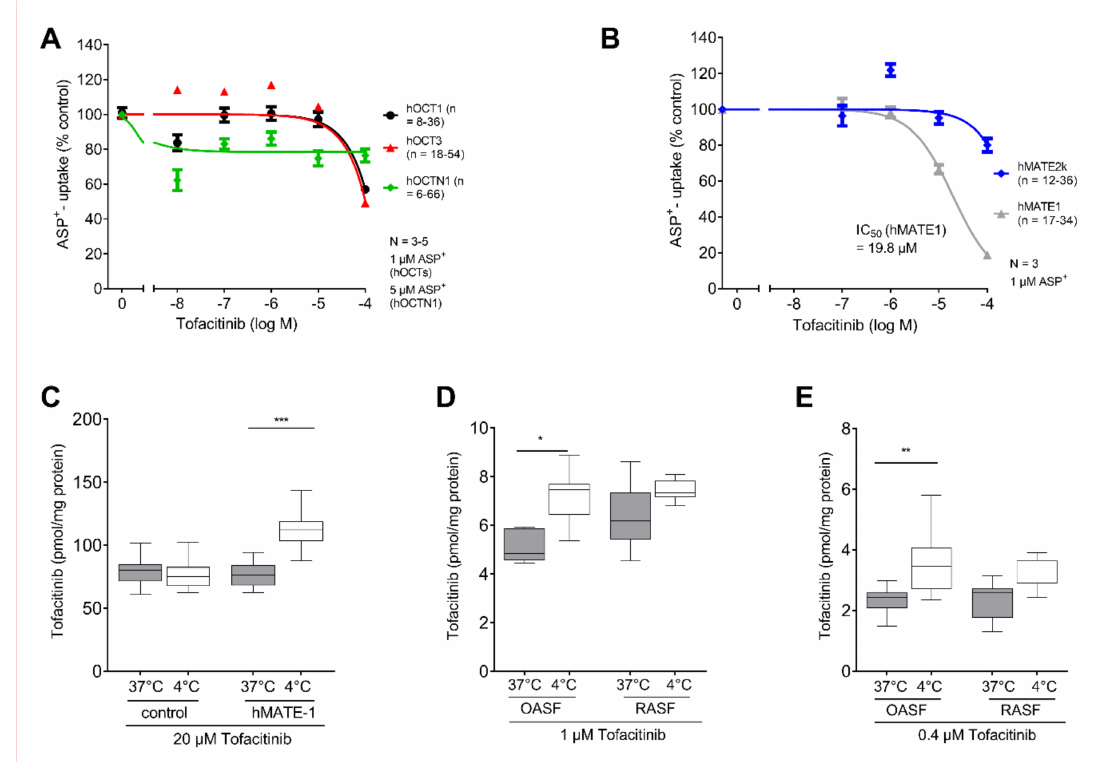
Figure 3. MATE-1 mediates Tofacitinib transport. ( A ) ASP + determined apparent a ffi nity of Tofacitinib to hOCT1, hOCT3 and hOCTN1. No significant interaction was observed ( n = 3–5). ( B ) ASP + determined apparent a ffi nity of hMATE1 and hMATE2k after intracellular acidification ( n = 3). MATE-1 shows an apparent a ffi nity IC50 = 19.8 µ M to MATE-1. Data in ( A , B ) are presented as mean ± SEM and fitted using a non-linear fit. ( C ) LC / MS determined intracellular Tofacitinib concentration of HEK cells (control) and HEK cells overexpressing MATE-1 at 37 ◦ C and 4 ◦ C ( n = 3). ( D ) LC / MS measurement of temperature dependent Baricitinib (1 µ M) uptake in RASF and OASF ( n = 3). ( E ) LC / MS measurement of temperature dependent Baricitinib uptake (0.4 µ M) in RASF and OASF ( n = 3). Statistical analyses were performed using a RM ANOVA and Sidak correction for multiple testing. Data in ( C , D ) are presented as box plot with whiskers indicating the min and max values, as well as the median. *: p < 0.05; **: p < 0.01; ***: p <